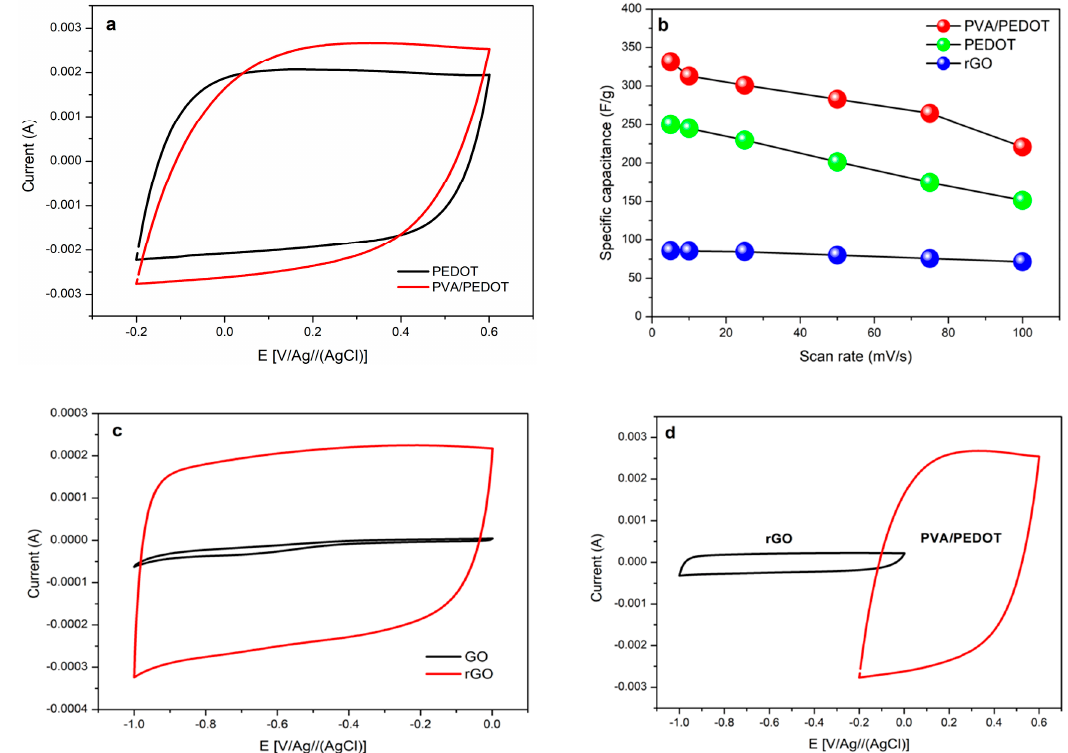
Figure 4. ( a ) Cyclic voltammetry (CV) profiles of PEDOT and PVA/PEDOT at 25 mV·s − 1 , ( b ) Capacitance values of PVA/PEDOT, PEDOT and rGO against sweeping rates (5–100 mV·s − 1 ). ( c ) CV profiles of GO and rGO at 25 mV·s − 1 . ( d ) CV profiles of rGO and PVA/PEDOT nanofibers measured in a three-electrode configuration in a 1.0 M KCl electrolyte at a sweeping rate of 25 mV·s − 1 ).